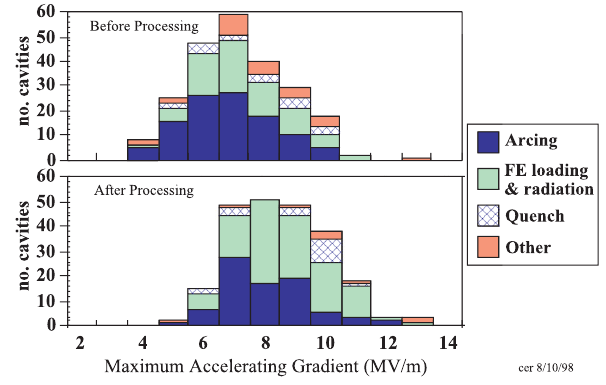
FIG. 12. 1996 operational envelope of CEBAF at reduced klystron power (from [81]).